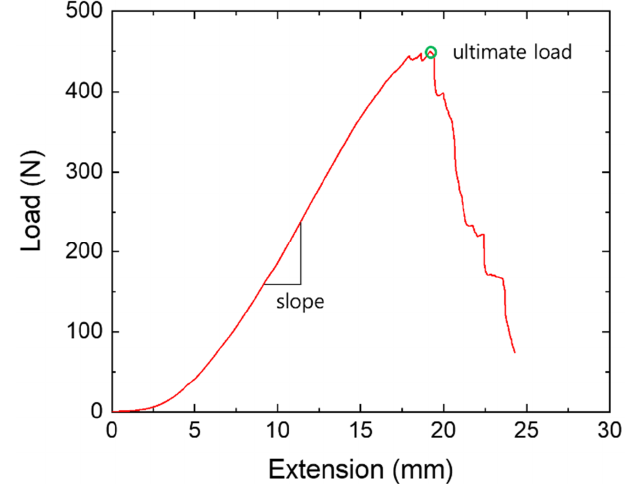
Figure 2. An MCL test curve and ultimate load, stiffness, and elastic modulus calculation. The slope represents stiffness in the load–extension curve and represents the elastic modulus in the stress–strain curve.